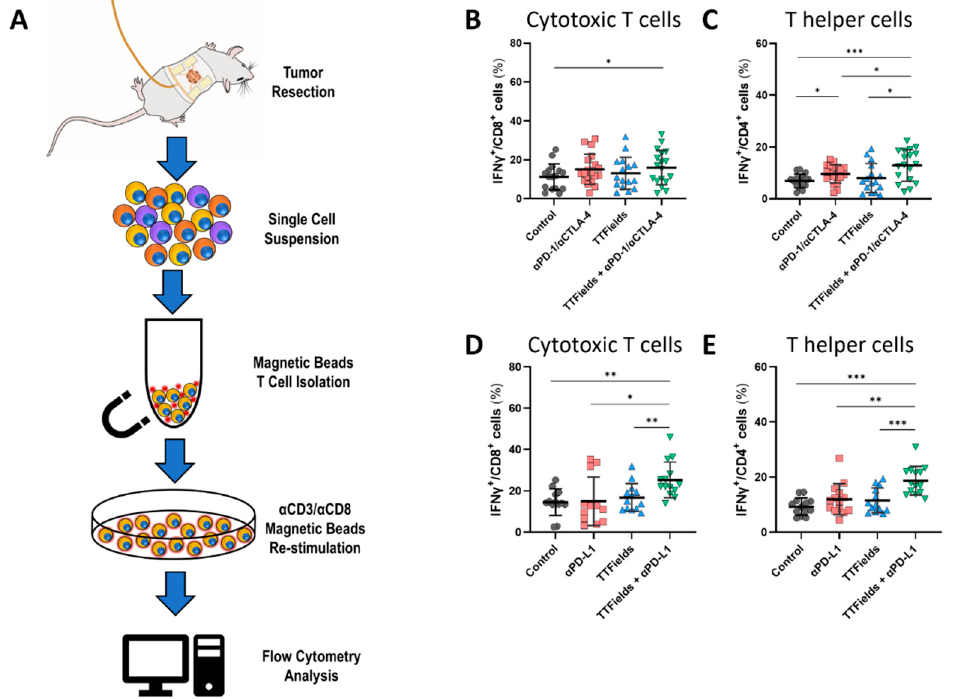
Figure 4. Co-application of TTFields and ICI increased the effector function of tumor-infiltrating T cells. ( A ) Tumor-infiltrating lymphocytes (TILs) were isolated and stimulated, and intracellular IFN- γ levels were examined. IFN- γ levels produced by CD8 + ( B ) and CD4 + ( C ) TILs from the anti-PD- 1/anti CTLA-4 ( α PD-1/ α CTLA-4) experimental set. IFN- γ levels produced by CD8 + ( D ) and CD4 + ( E ) TILs from the anti-PD-L1 ( α PD-L1) experimental set. Values are mean ± SD. * p < 0.05, ** p < 0.01, and *** p < 0.001; Student’s t